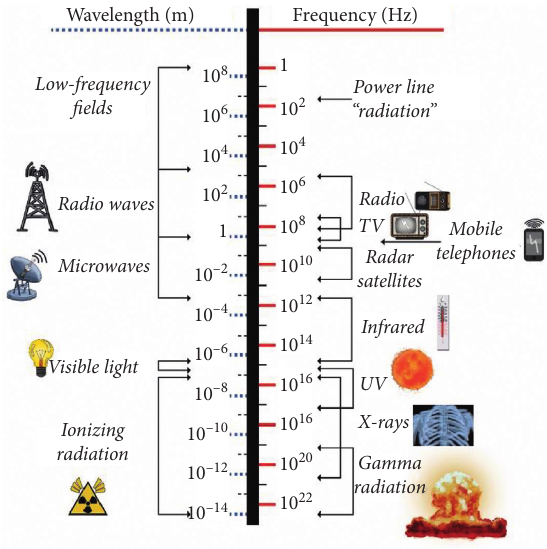
Figure 1: Electromagnetic spectrum.